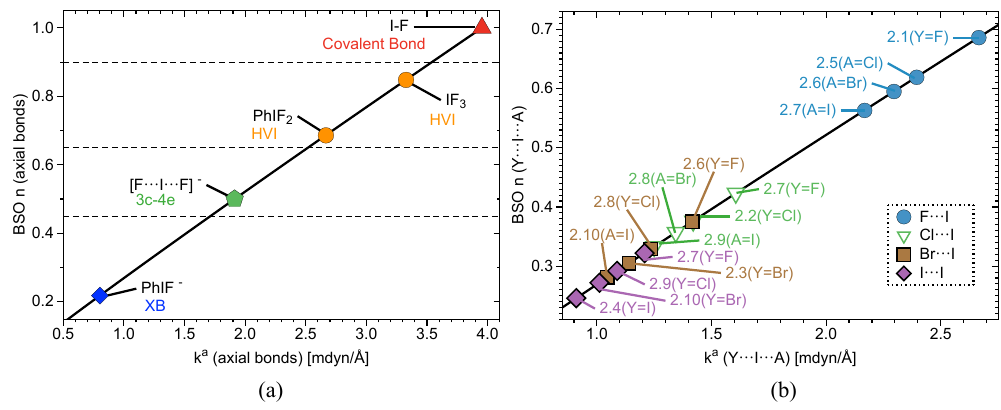
Figure 2. ( a ) Power relationship between bond strength order (BSO) n and k a of Group 1 bonds (axial bonds only in the case of PhIF − , PhIF 2 , and IF 3 ) according to eq 2 and ( b ) BSO n versus k a of Y · · · I · · · A bonds for complexes 2.1–2.10 , where Y and A are halogen atoms.